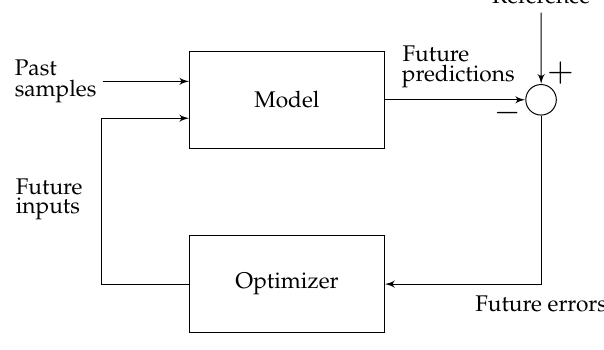
Figure 9. Structure of MPC algorithm.